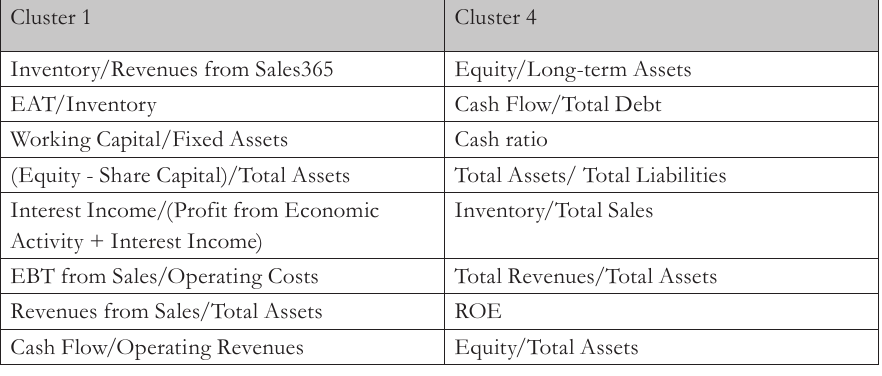
Tab. 2 – Clusters of the analyzed financial ratios. Source: own research Cluster 1 Cluster